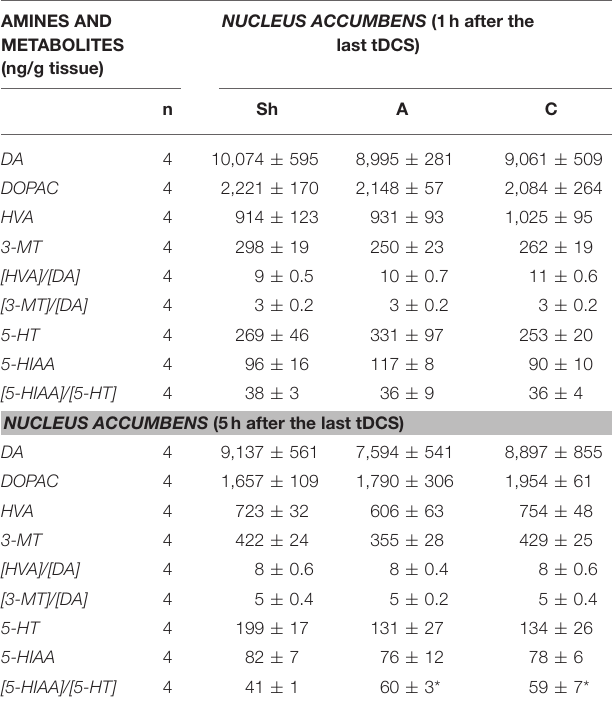
TABLE 6 | The effect of repetitive anodal (A) and cathodal (C) tDCS on the concentration of monoamines (DA, and 5-HT), their metabolites and on the rate of metabolism at different time point after the last stimulation investigated in NUCLEUS ACCUMBENS. AMINES AND METABOLITES (ng/g tissue)